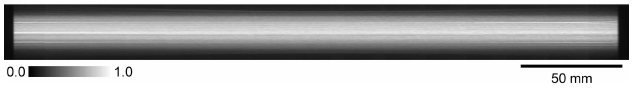
Figure 7 Beam profiles of the ( a ) 110 keV DMM at EH3 and ( b ) 40 keV DMM at EH3.